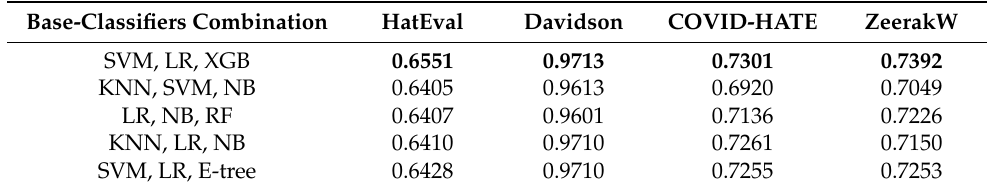
Table 7. F1-score of the stacking ensembles using different base classifiers on test sets. Bold entries show the highest performance for each classifier on each dataset.